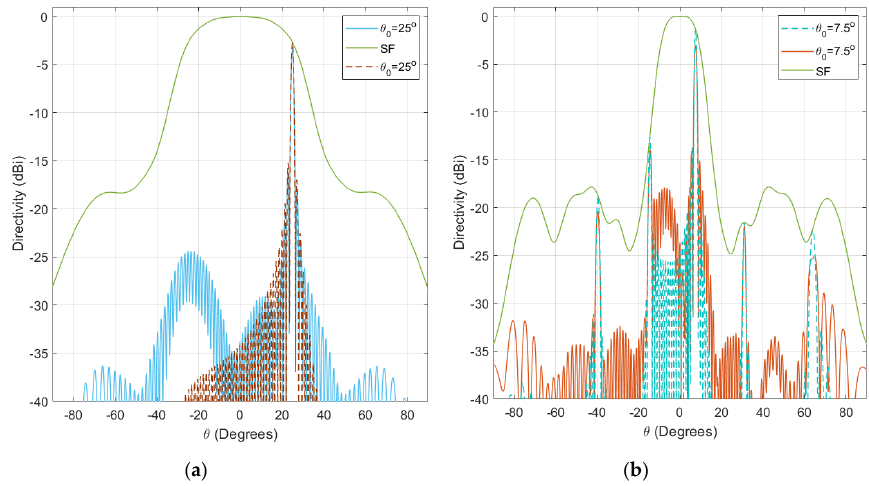
Figure 12. Comparison of the radiation pattern of the 65 × 19 calculated by the proposed approach (solid line) versus an approach that assumes identical embedded radiation (dotted line) for the ( a ) H-plane and ( b ) E-plane. The figure also includes the embedded radiation pattern of the central sub-array of the 11 × 5 array (SF).